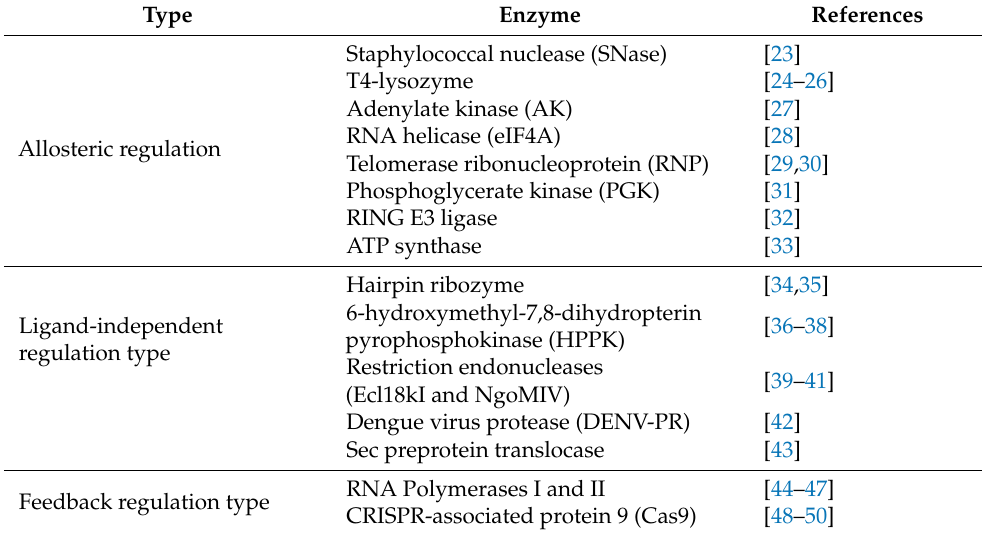
Table 1. List of available reports on the study of enzyme conformational dynamics using smFRET.